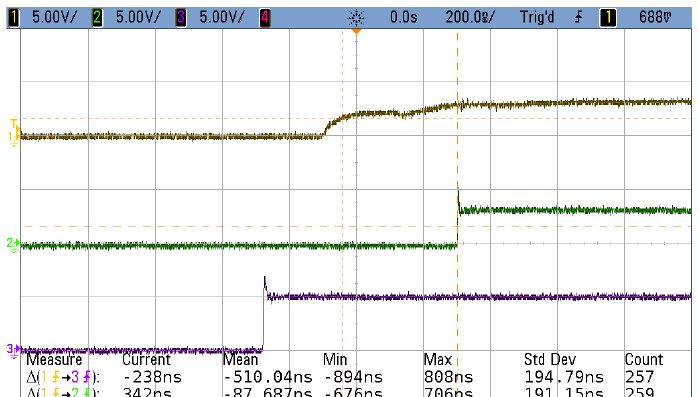
Figure 17. Sample PPS accuracy measurement. PPS signal edge differences between the GPS (top), core (middle) and reference server (bottom) are measured several times using a digital oscilloscope. Statistics are automatically calculated by the instrument. Table 7. Accuracy to the reference GPS PPS signal in nanoseconds. NTP Server NTP Test